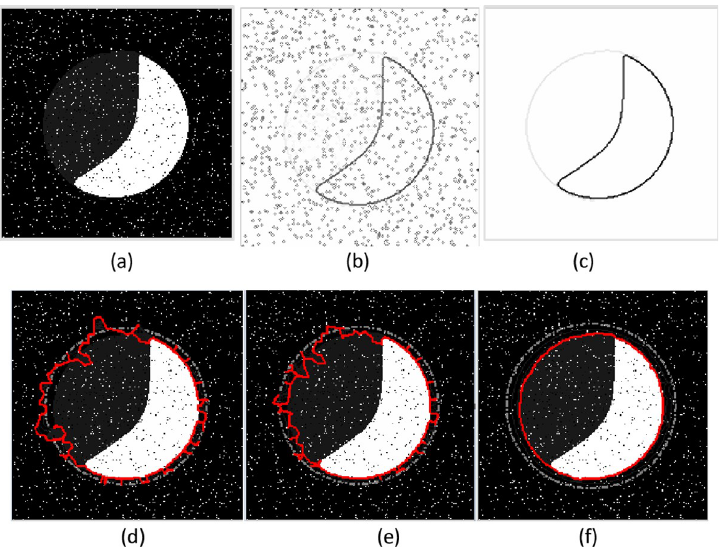
Fig 7. Example of weak edge preservation and noise suppression. (a) The crescent image,(b) edge map with noise, (c) edge map without noise, segmentation results of (d) the GVF snake with μ = 0.1, (e) the VEF snake, and (f) the MCONVEF snake with k = 0.1, h = 1.2 and L = 2. The gray dash point circles are the initial contours, and the solid lines in red are the converged results.